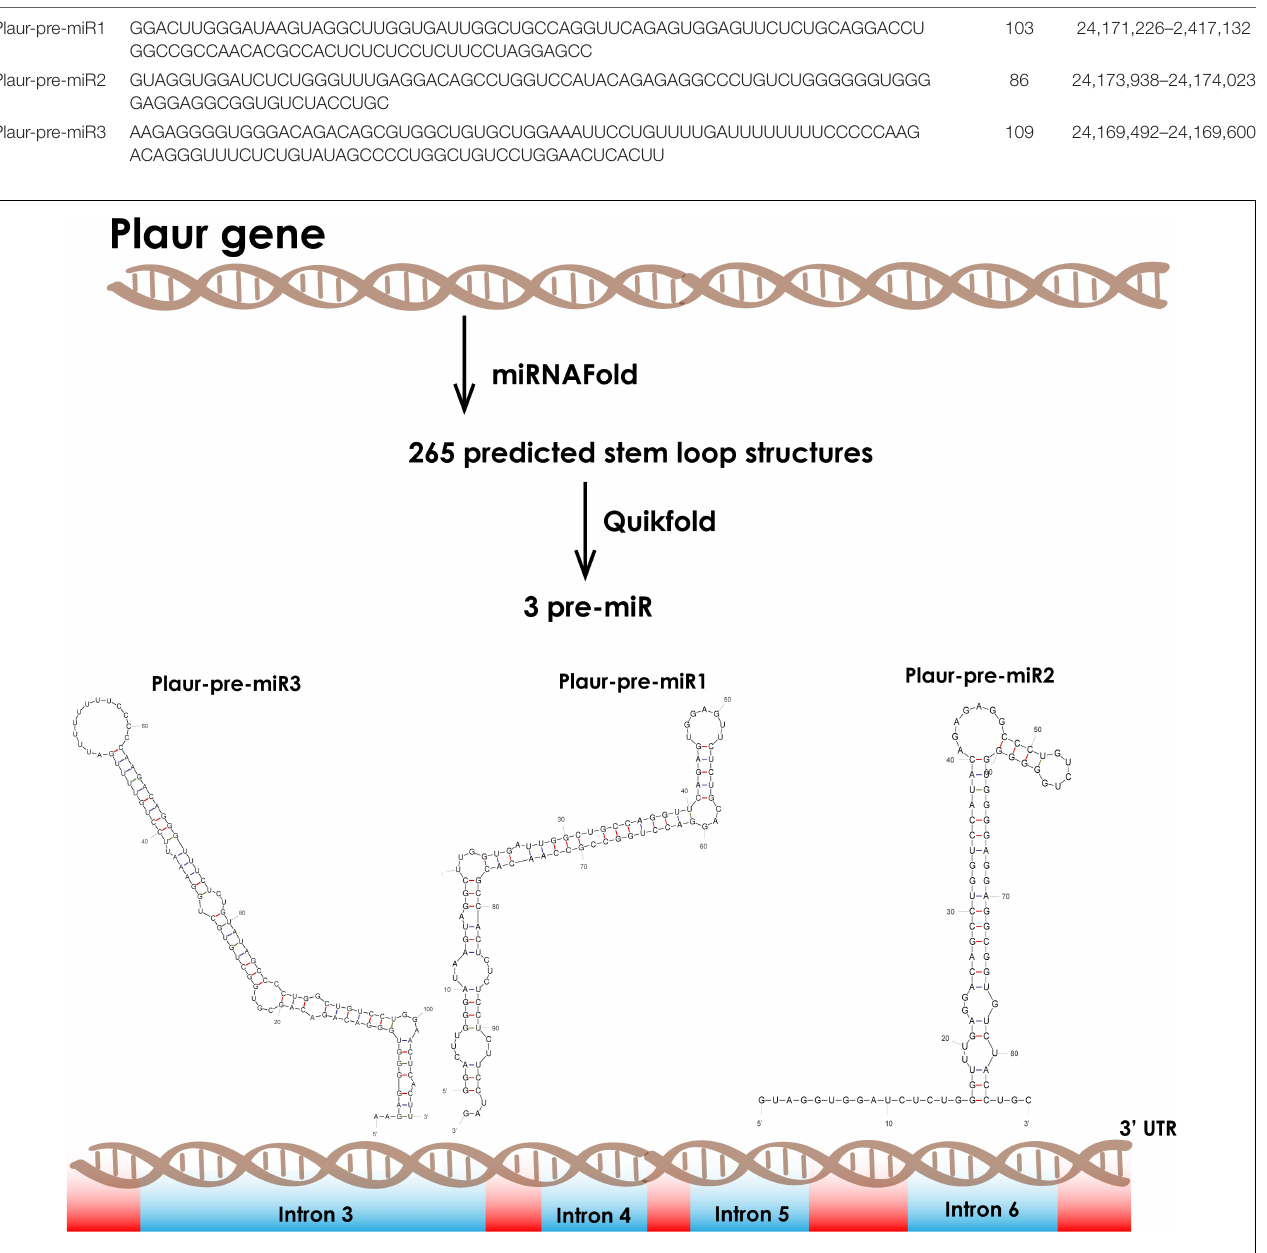
FIGURE 1 | Computational prediction of novel small RNAs in the Mus musculus Plaur gene. We applied the miRNA Fold software to predict miRNA precursor hairpin structures located in Plaur . We then used the Quickfold service for subsequent visualization and analysis of 256 predicted stem-loops. We identified three stem-loop structures with high probability to be miRNAs according to the intronic localization, overall stability ( ≤ − 15 kJ/mol) and consensus motifs that are critical for Drosha processing. Plaur-pre-miR1 and Plaur-pre-miR3 are located in intron 3 and Plaur-pre-miR2 is located in intron 6. Introns are highlighted in blue; exons are highlighted in